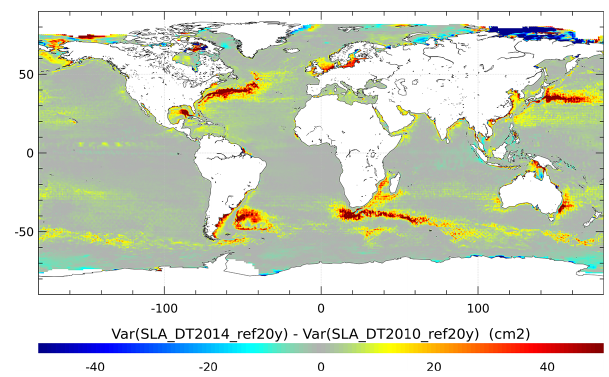
Figure 7. Difference between SLA variance observed with DT2014 gridded products and SLA variance observed with DT2010 prod- ucts over the [1993–2012] period. Gridded products merging all the altimeters available are considered (i.e., “all-sat-merged” in DT2014; “UPD” in DT2010). DT2010 products were referenced to the 20-year altimeter reference period and interpolated onto the 1 / 4 ◦ × 1 / 4 ◦ Cartesian grid for comparison with